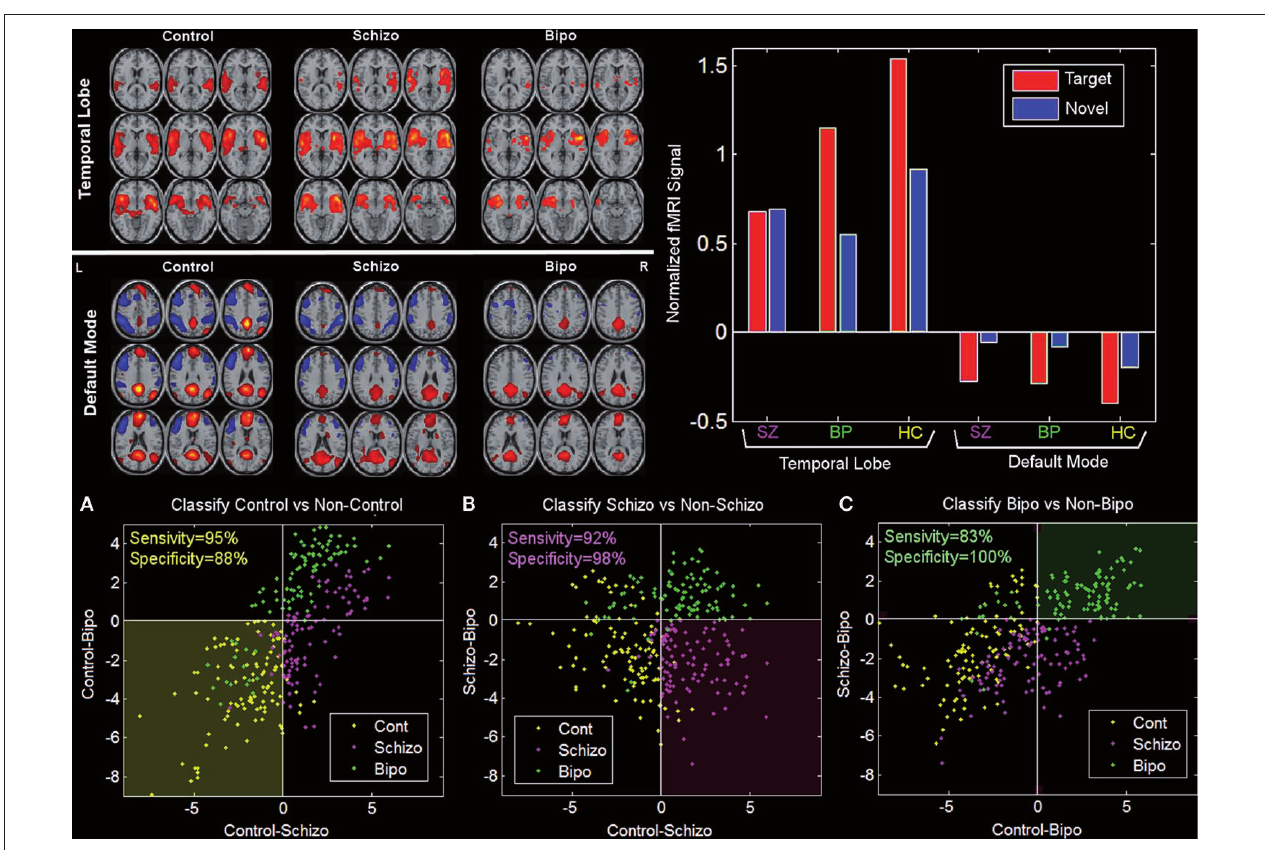
FIGURE 1 | Pair-wise comparisons of the control, schizophrenia, and bipolar groups (from Calhoun et al., 2008b). Two-sample t -tests were performed to illustrate most signifi cant differences for each pair-wise comparison (top left). Note that these maps are generated from all subjects and actual classifi cation regions will be slightly different due to the leave-1-out approach. On the top right is plotted the average beta weights for the stimuli broken out by group. On the bottom is shown a priori decision regions for three-way classifi cation for (A) control (dark yellow) versus non-control (black),